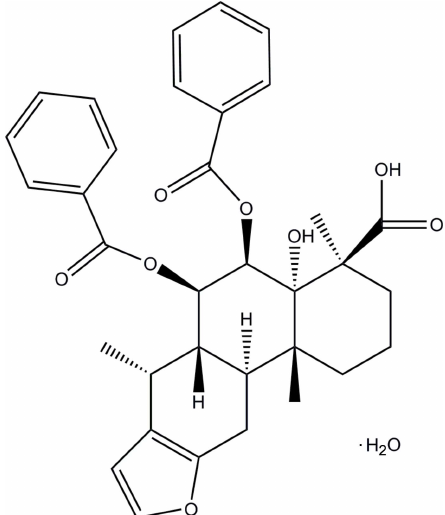
Table 1 Hydrogen-bond geometry (A˚ , (cid:3) ).